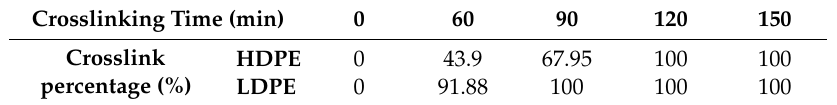
Table 2. Aromatization index values of LDPE/HDPE sheath-core fibers for various crosslinking time at 130 °C.